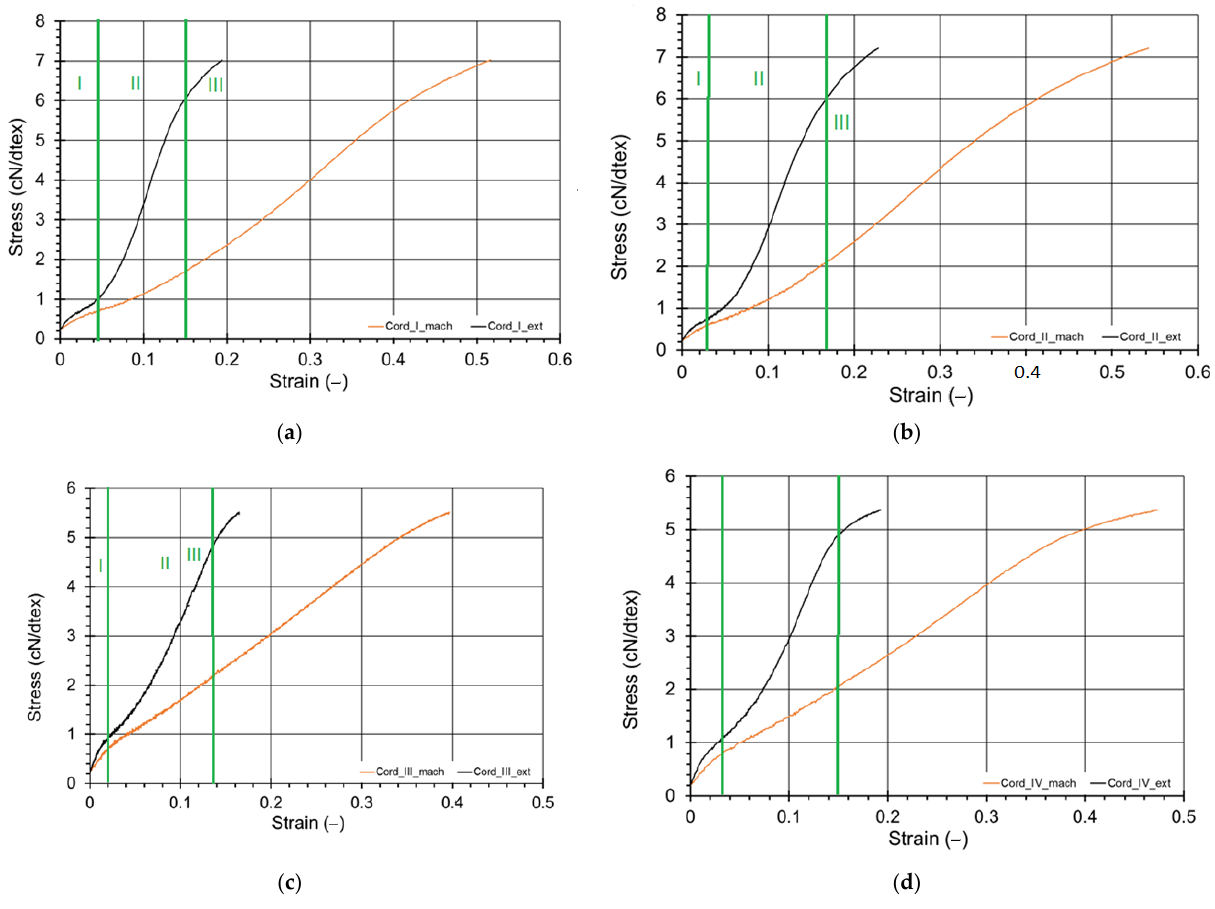
Figure 8. Stress − strain curves for ( a ) cord I, ( b ) cord II, ( c ) cord III and ( d ) cord IV, where “_mach” means the results from the testing machine measurement head, “_ext” − measurement by videoextensometer.